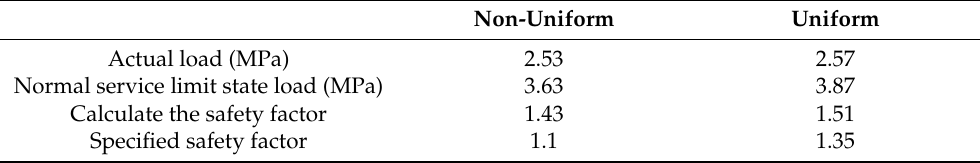
Table 8. Comparison of the calculation results of the two